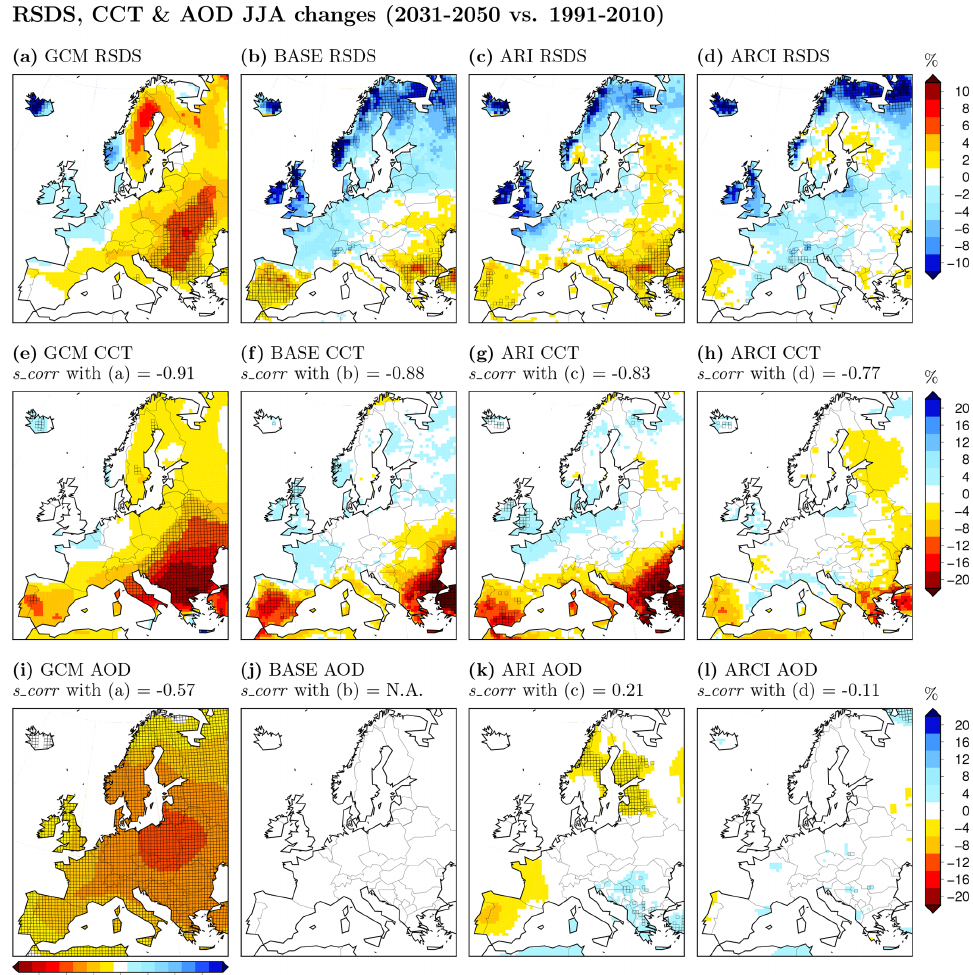
Figure 7. Projected changes for the RSDS (a–d) , CCT (e–h) and AOD (at 550nm) (i–l) summer (JJA) climatologies by the GCM (first column) and the WRF experiments (second to fourth columns; units: percent). Squares highlight statistically significant signals ( p < 0.05). Note that panel (i) refers to the horizontal color bar just below it. Spatial correlations ( s_corr ) between the patterns in the second and third rows and the respective patterns in the first row are indicated in the